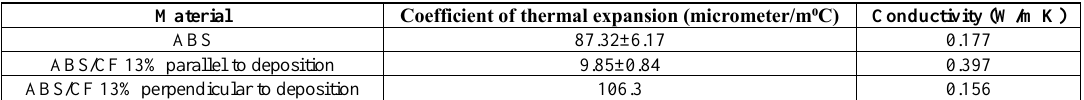
Table 4. Coefficient of thermal expansion and thermal conductivity of ABS